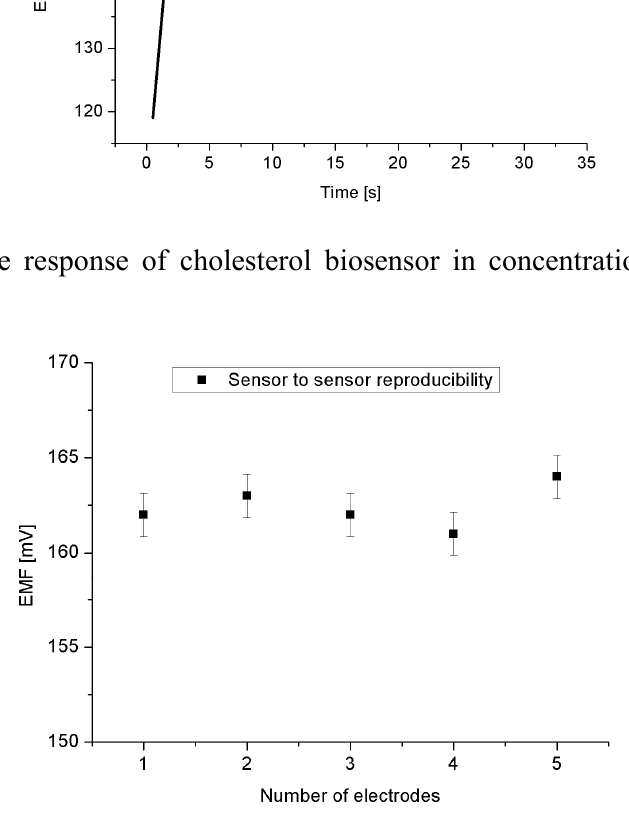
Figure 7. The reproducibility for five working electrodes in a 5 × 10 − 6 M of